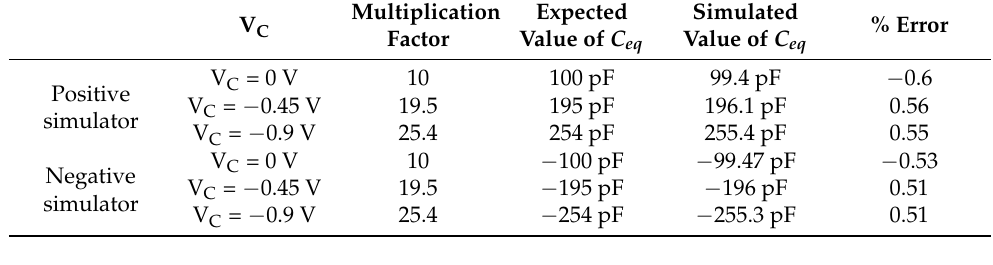
Figure 8. Frequency response of magnitude (blue) and phase (red) for the proposed ( a ) positive and ( b ) negative floating capacitor simulator. Figure 9. Application of the proposed simulated floating C as a high pass filter.